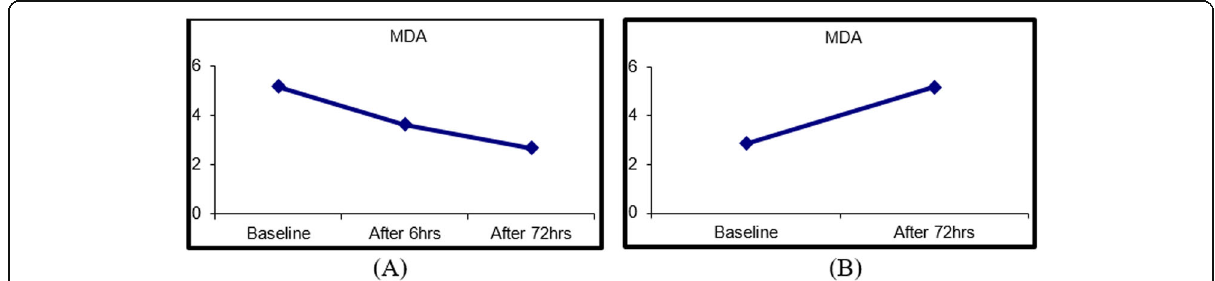
Fig. 1 MDA mean levels in ( a ) MT group (baseline, after 6 h, and after 72 h) and ( b ) CT group (baseline and after 72